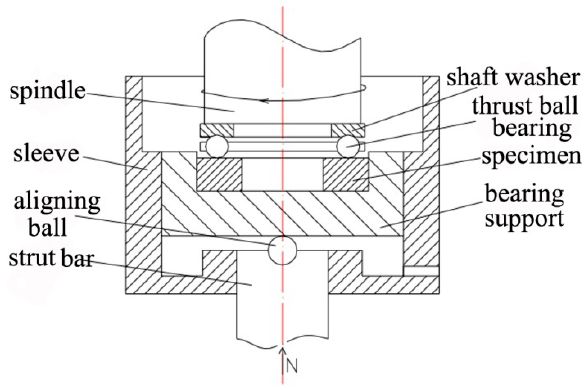
Figure 2. Sketch of RCF testing principle.